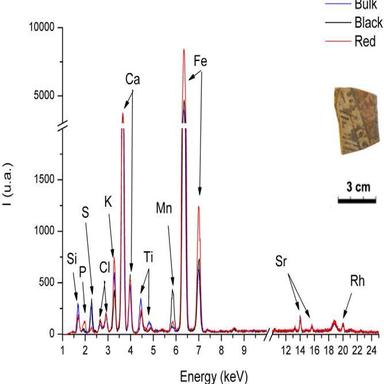
Comparison between XRF spectra obtained in the bulk (blue), black (black) and red (red) decoration (sample Rip. 18). (For interpretation of the references to color in this figure legend, the reader is referred to the web version of this article.)